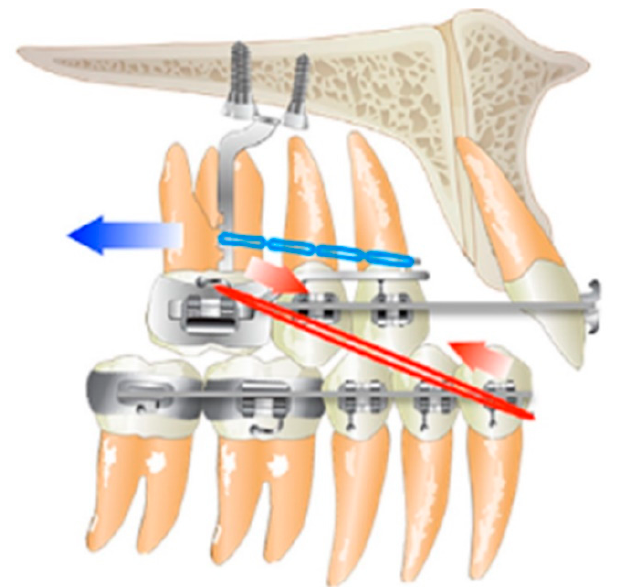
Figure 1. Schematic drawing of Class III elastics and a maxillary MCPP for total arch